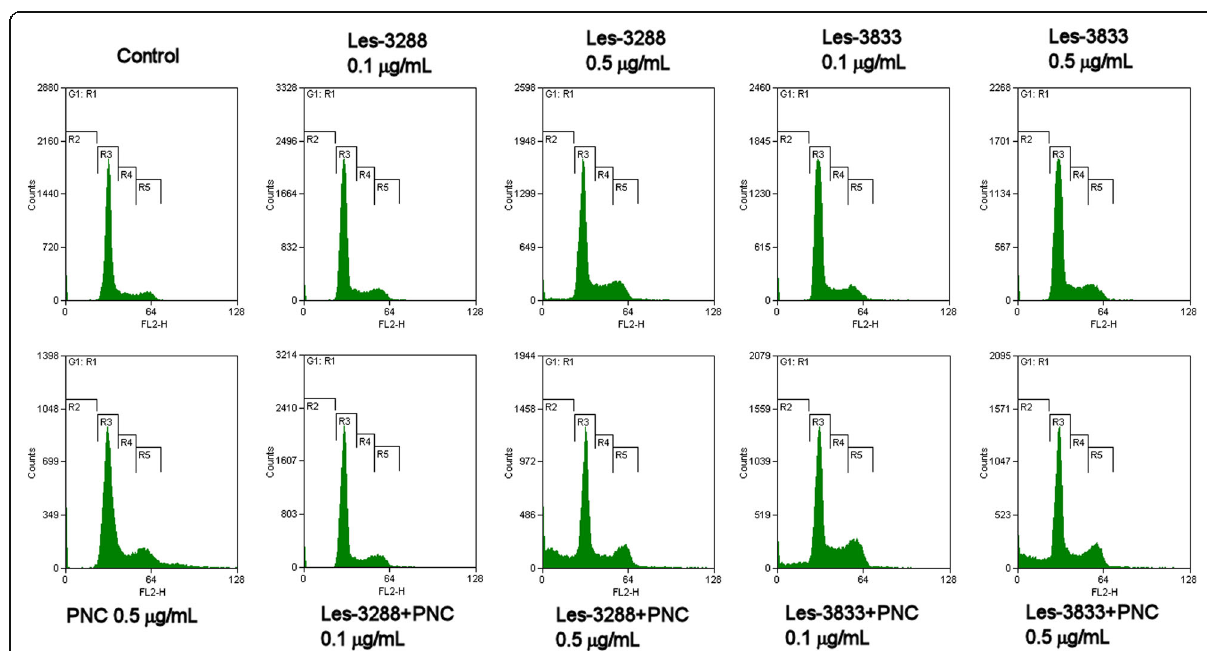
Fig. 7 Impact on cell cycle progression of 4-thiazolidinone derivatives Les-3288 and Les-3833 in free form and in complex with the polymeric nanocarrier (PNC) in C6 rat glioma cells. Propidium iodide (PI) staining, flow cytometry. R2, pre-G1; R3, G1; R4, S; R5, G2 phase. FL2-H, peak emission values of the second channel (585/40 filter) of flow cytometer